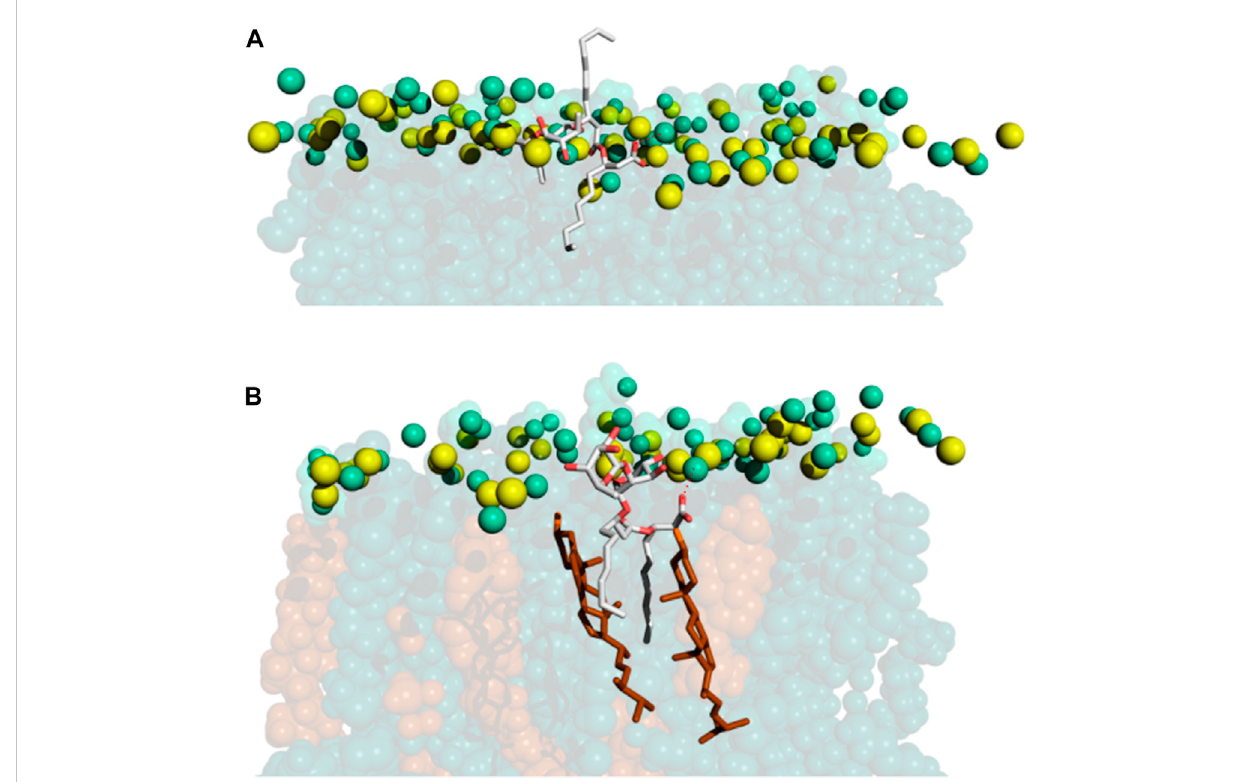
FIGURE 8 MD snapshots showing how (A) RLs get inserted in POPE/ERGO (70/30) model membranes and how, (B) once inside, they recruit ergosterol, forming microdomains. RLs are represented in sticks (carbon in grey and oxygen in red). For membrane colouring refer to the caption of Figure 4. Electrostatic interactions are shown as red dotted